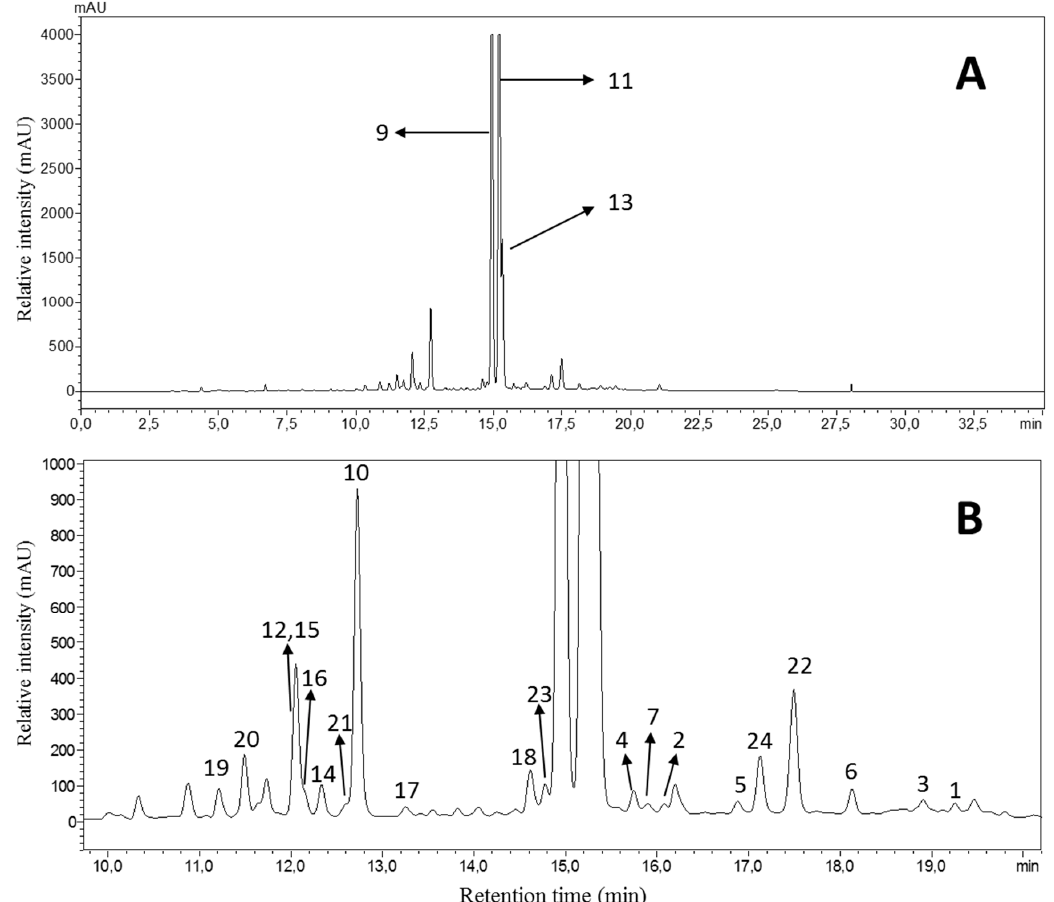
Figure 3. Chromatogram of the HPLC-DAD analysis of the diethyl ether subfraction ( A ) and an enlarged view ( B ) at λ 254 nm obtained from the methanolic extract of the aerial parts of D. diapensifolia .